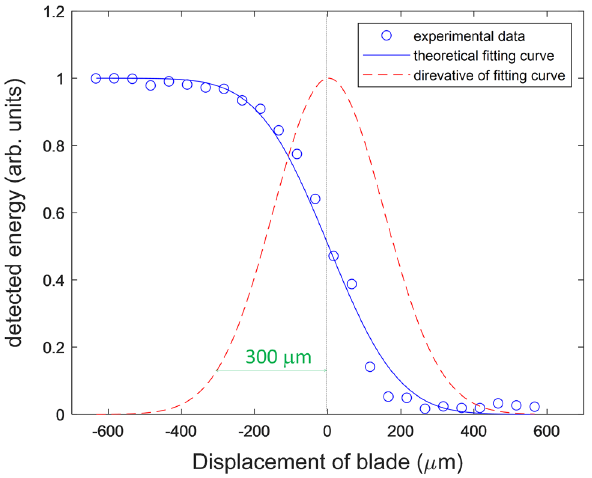
Figure 8. Knife-edge measurement of the focused 5.7-THz imaging beam. The blue line is the fitting curve of the experimental data (blue open dots) based an integrated Gaussian-intensity function. The red line is the derivative of the blue curve, indicating a Gaussian field radius of 300 μm.